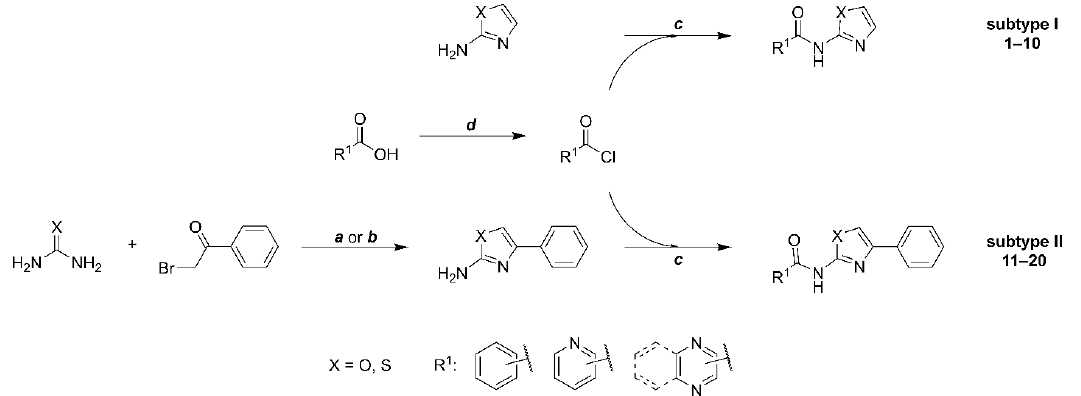
Figure 2. Synthetic procedures used to prepare title compounds. Condition a: (for X = S) 1.1 eq. urea, in EtOH, reflux 2 h; b: (for X = O) 10 eq. urea, in MeCN, reflux 16 h or in DMF, 120 °C 2 h; c : 1 eq. acyl chloride, 3 eq. DIPEA or pyridine, in DCM, overnight; d : 10 eq. thionyl chloride, catalytic DMF.